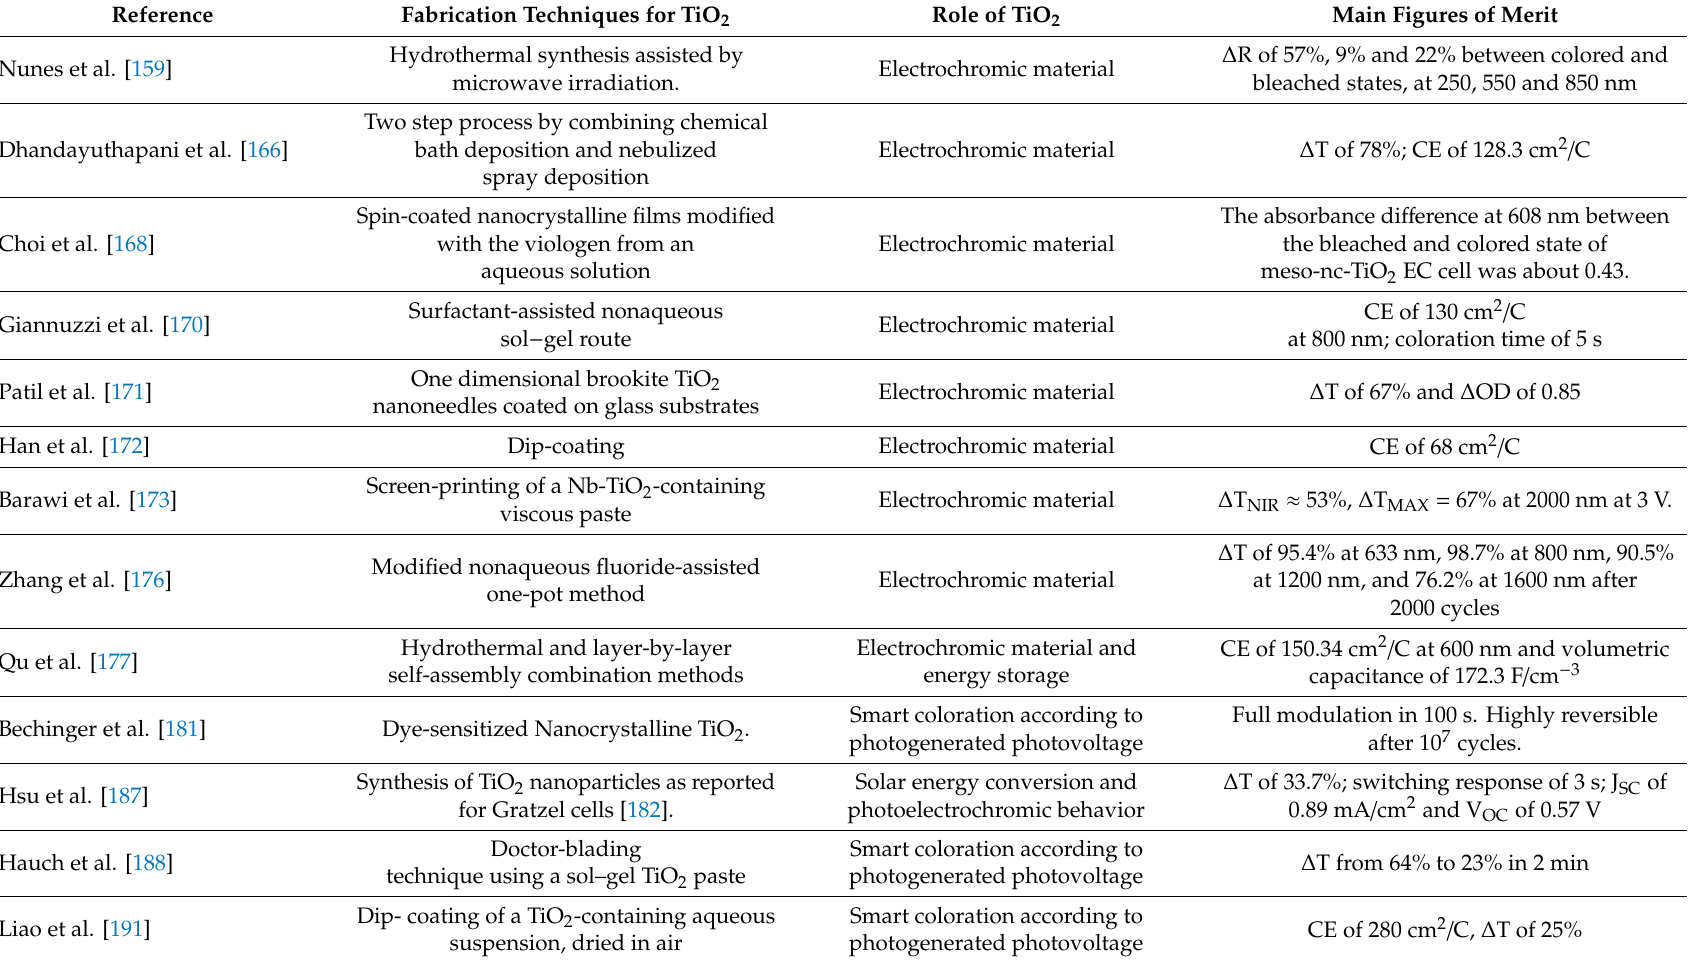
Table 2. Fabrication techniques, role of TiO 2 and figure of merits of EC